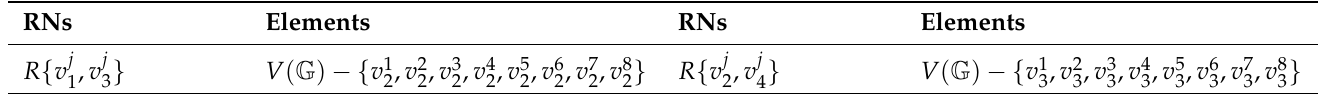
Table 10. RNs ´ R u for 1 ≤ u ≤ 16 and 1 ≤ j ≤ 8.